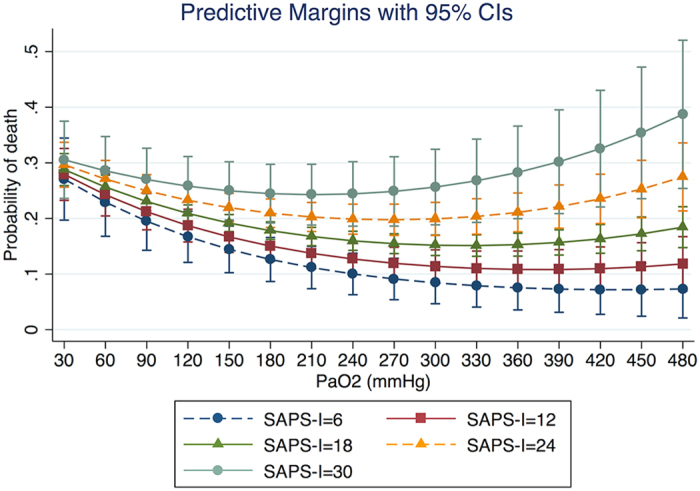
The relationship between PaO2 and mortality risk at different levels of severity of illness.Covariates except for SOFA were adjusted for in each curve. As expectedly, patients with SAPS-1 = 30 showed highest risk of death and the nadir of the curve was at the PaO2 value of 210 mmHg. In contrast, those with SAPS-1 = 6 showed the lowest risk of death across the entire PaO2 range, and the curve reaches a nadir at the PaO2 value of 420 mmHg.